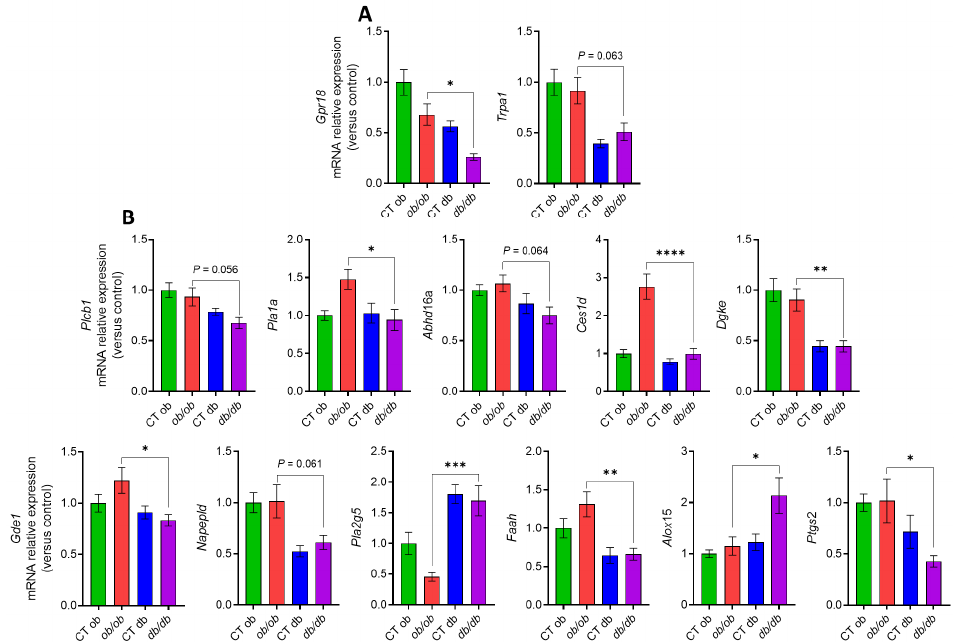
Figure 3. Different mRNA expression, in the duodenum of ob/ob and db/db mice, of eCBome related receptors ( A ) and metabolic enzymes ( B ) for 2-monoacylglycerols and N -acylethanolamines measured by qPCR-based TaqMan Open Array. Data are presented as the mean ± S.E.M of n = 7–10. * p ≤ 0.05, ** p ≤ 0.01, *** p ≤ 0.005, **** p ≤ 0.001. Relative units were calculated versus the mean of the CT ob mice values set at 1. Data were analyzed by one-way ANOVA followed by Tukey’s post hoc test. Abbreviations: see Supplementary Table S2.